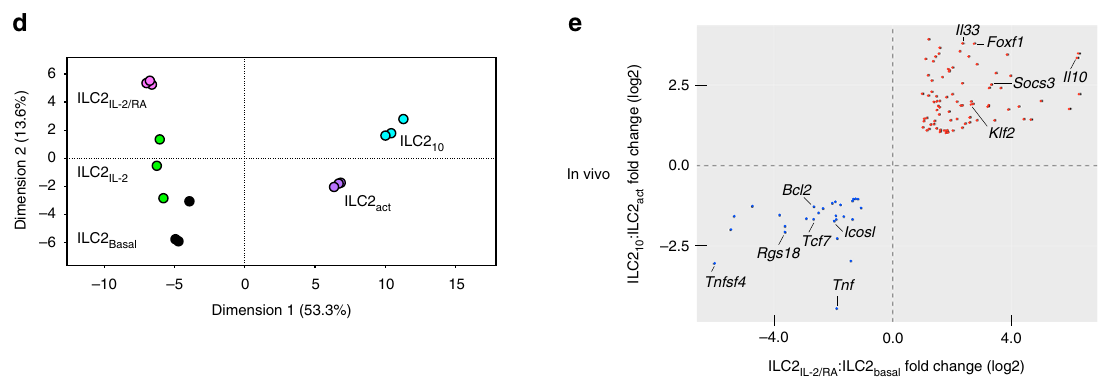
Fig. 5 Expression pro fi le of in vitro generated ILC2 10 . a , b ILC2 from untreated ( a ) or IL-33-treated ( b ) wildtype mice were sorted and 5000 cells cultured for 6 days in the presence of IL-7 and IL-33 with the addition of indicated cytokine(s) and/or RA. Culture supernatants were harvested for IL-10 and IL-13 determination, and total cells were counted. c RNA-seq analysis of differentially expressed genes from in vitro stimulated ILC2 as indicated (ANOVA test with Benjamini and Hochberg correction). Examples of genes contained within each cluster (I, II, III, IV) are listed to the right of each cluster. d Principal component analysis of RNA-seq data presented in c and compared to isolated ILC2 10 or ILC2 act from IL-33 injected mice. e Genes that were either upregulated (top right quadrant) or downregulated (bottom left quadrant) in indicated groups. Data are from three a – e independent experiments with two ( a , b ) or four ( c – e ) animals pooled per experiment. Error bars are standard deviation ***P < 0.001, **P < 0.01, *P < 0.05 and ns (not signi fi cant, P ≥